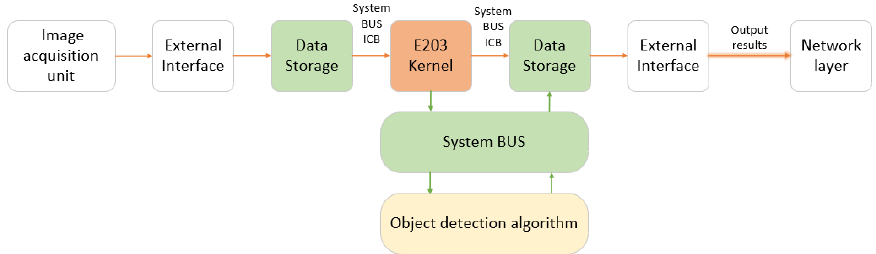
Figure 1. Structure diagram of the target detection algorithm accelerator.